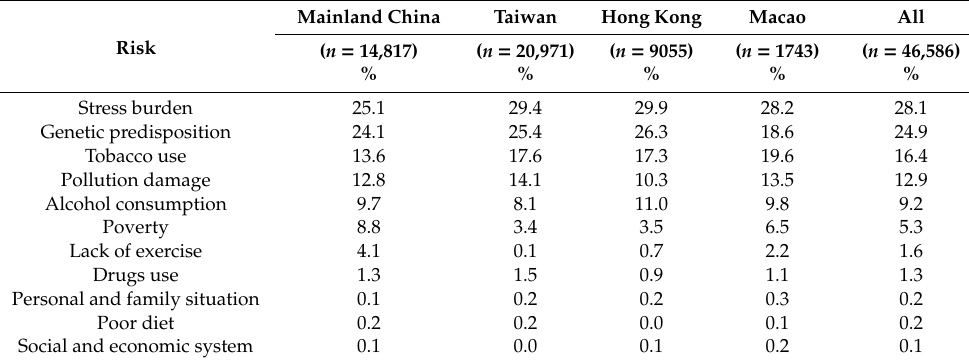
Table 2. Risk assessment of NCDs coverage in mainland China and Taiwan, Hong Kong, and Macao between